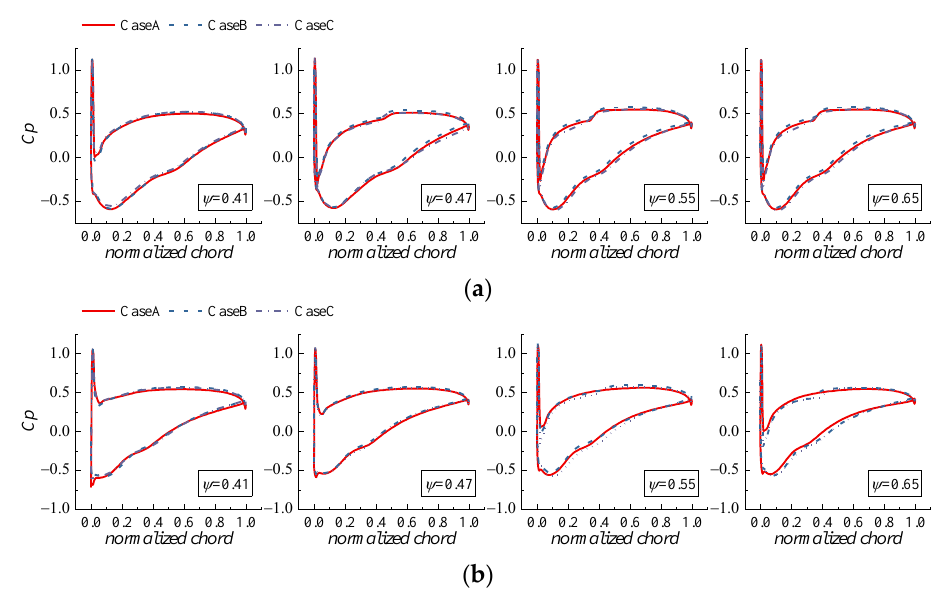
Figure 17. The distribution of rotor static pressure rise coefficient at midspan: ( a ) design condition; ( b ) near stall condition.